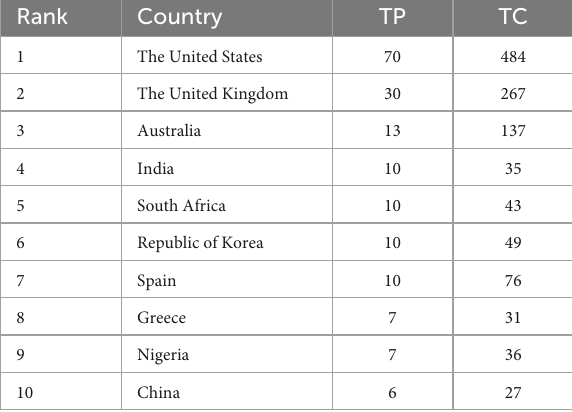
TABLE 3 Rankings of countries with a total number of publications and